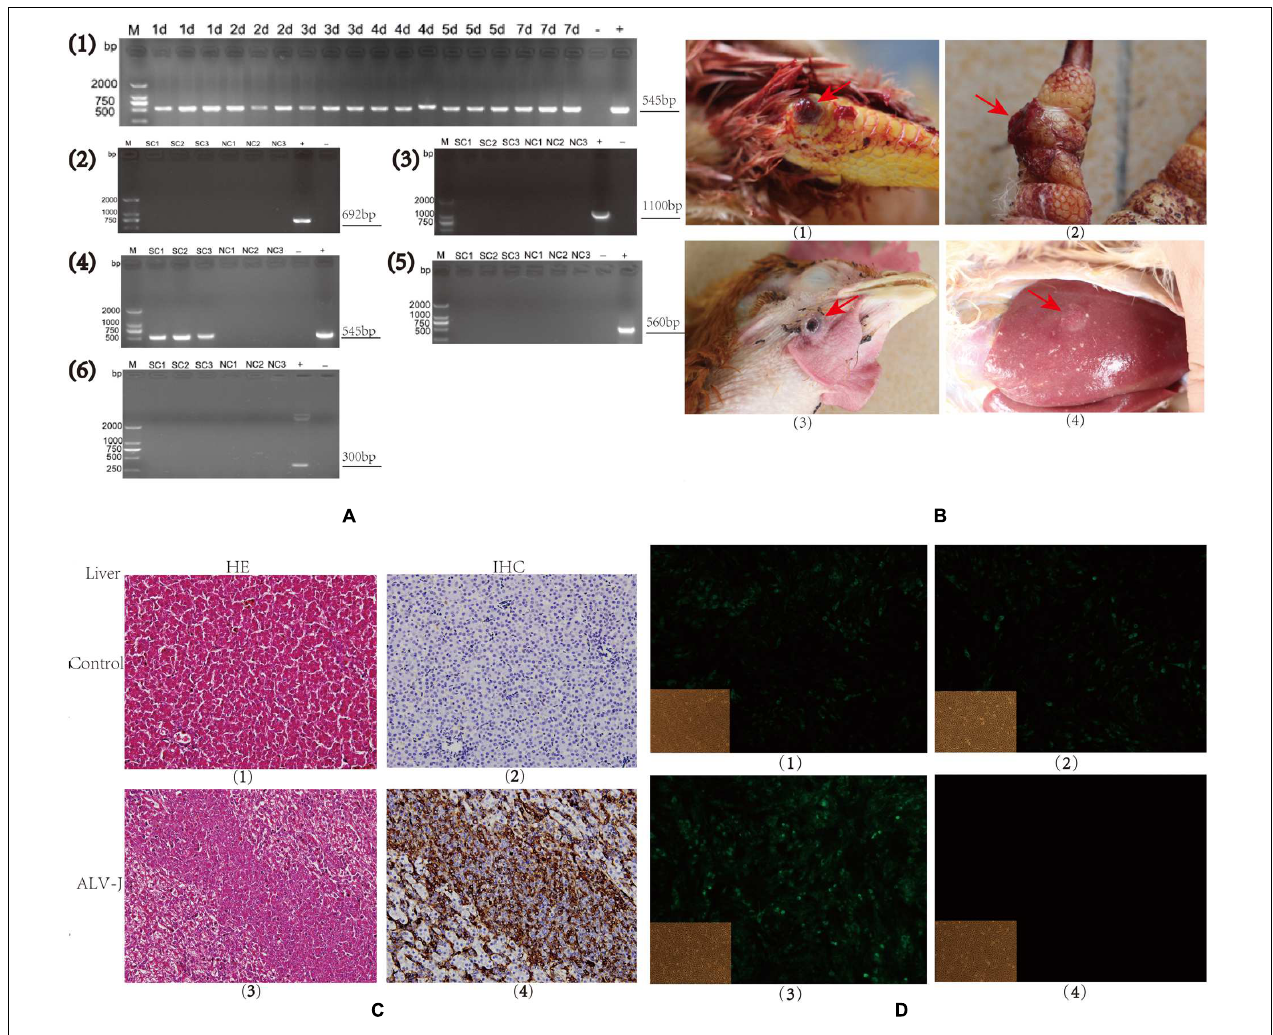
FIGURE 1 | Detection of avian leukosis virus subgroup J (ALV-J) in specific-pathogen-free (SPF) chicks and clinical samples. (A) . Agarose gels of RT-PCR and PCR products from chicken samples using virus-specific primer sets. (1). Time course of an SCAU-HN06 infection in SPF chicks using primers H5/H7 by RT-PCR. (2–6). PCR results using primers specific for (2). ALV-A, (3). ALV-B, (4). ALV-J, (5). MDV, and (6). REV in clinical samples. Chicken sample names are listed above each gel lane; (–) negative control, ( + ), positive control, bp = base pairs. Numbers on the left indicate lengths of molecular weight standards. (B) . Photographs of tumors (arrows) from infected (SC group) chickens: (1). Joint hemangioma, SC1 (2). Digit hemangioma, SC2; (3) Neck hemangioma, SC3 (4) Liver tumor, SC3. (C) . Liver tissues from an uninfected (NC3) and an ALV-J-infected chicken (SC3; 400 × magnification). (Panels 1 and 3) Hemotoxylin and eosin (HE) staining; (Panels 2 and 4) Immunohistochemical staining for virus-specific protein gp85 using monoclonal antibody JE9. (D) . Immunofluorescence of DF-1 cells using an ALV-J-specific antibody JE9 (150 × magnification). (1, 2, and 3) Cells infected using virions isolated from chickens SC1, SC2, and SC3; (4) Uninfected DF-1 cells as negative